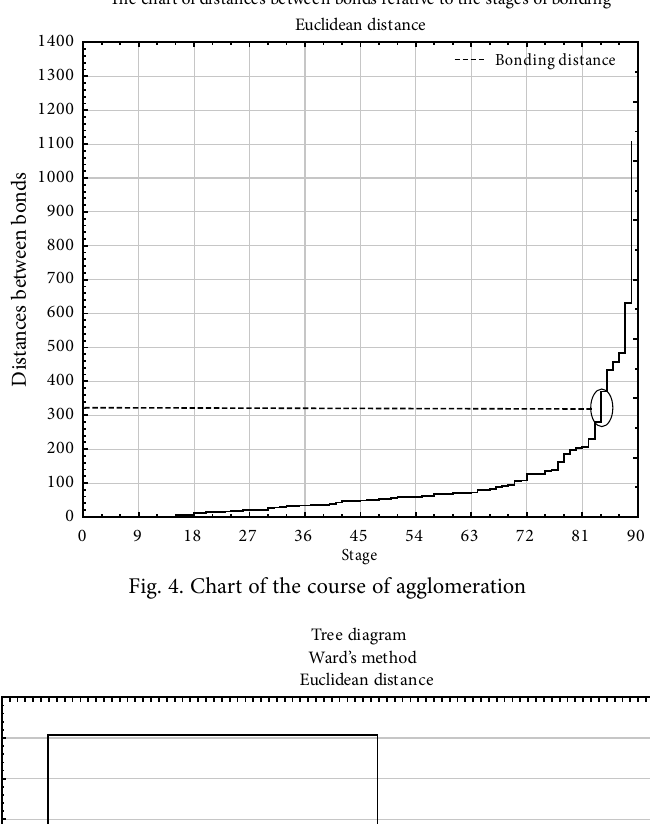
Fig. 4. Chart of the course of agglomeration